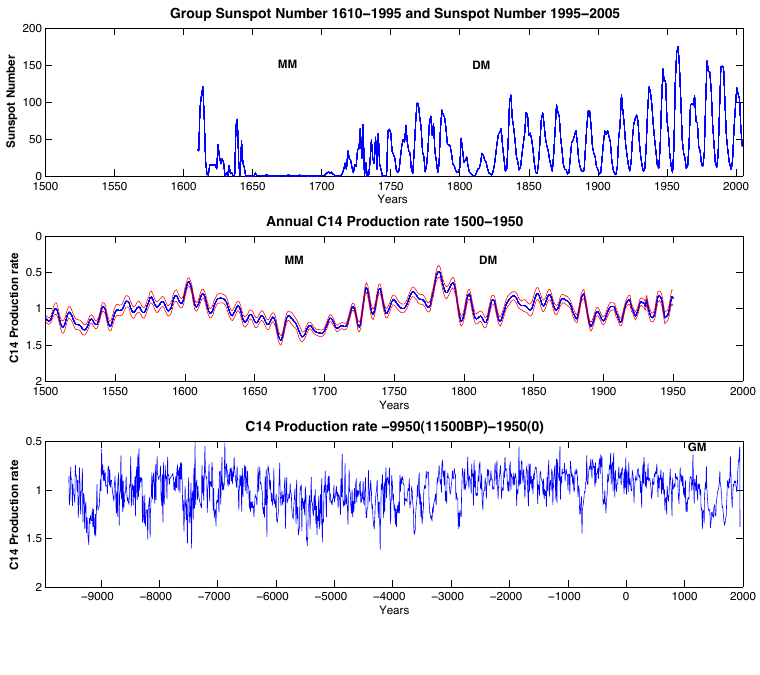
Fig. 1. Upper panel shows group sunspot number R G 1610–1995 and sunspot number R z 1995–2005. Middle panel shows the 14 C production rate from 1500–1950. Lower panel shows the 14 C production rate from − 9950 BC–1950. MM stands for Maunder Minimum, DM for Dalton Mimum and GM for Grand